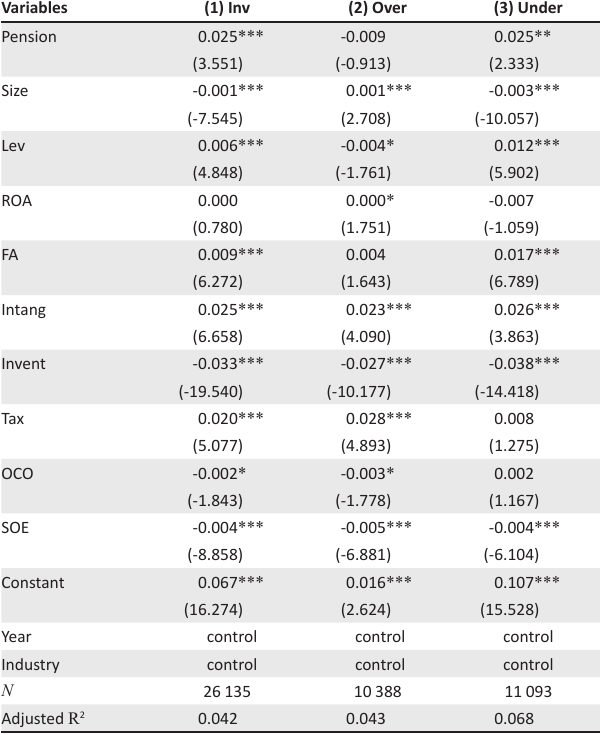
TABLE 7: Association between defined pension contributions, free cash flow and investment inefficiency.